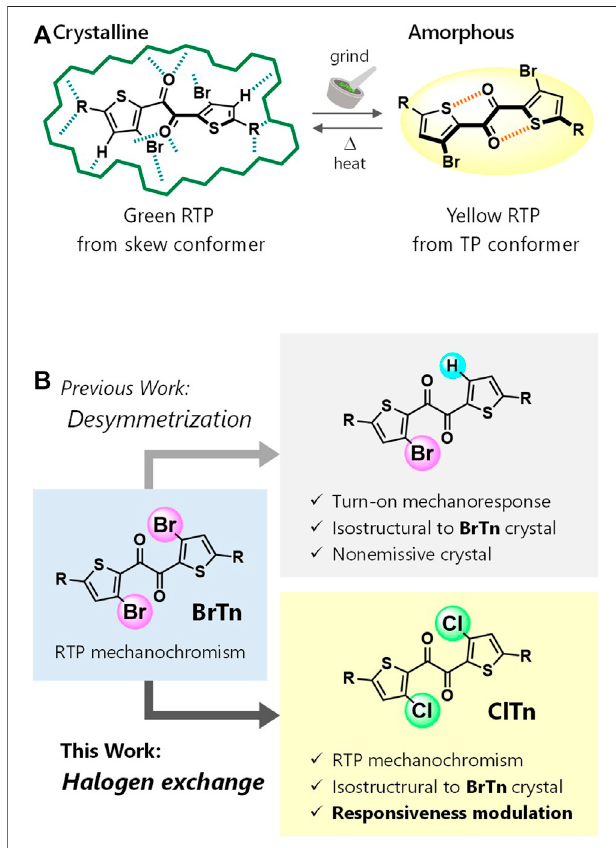
FIGURE 1 | (A) Schematic depicting the RTP-to-RTP mechanochromism of BrTn . Green hashed lines represent intermolecular interactions, whereas orange ones represent intramolecular chalcogen bonds. (B) Molecular design for modulating mechanoresponsive RTP. R,